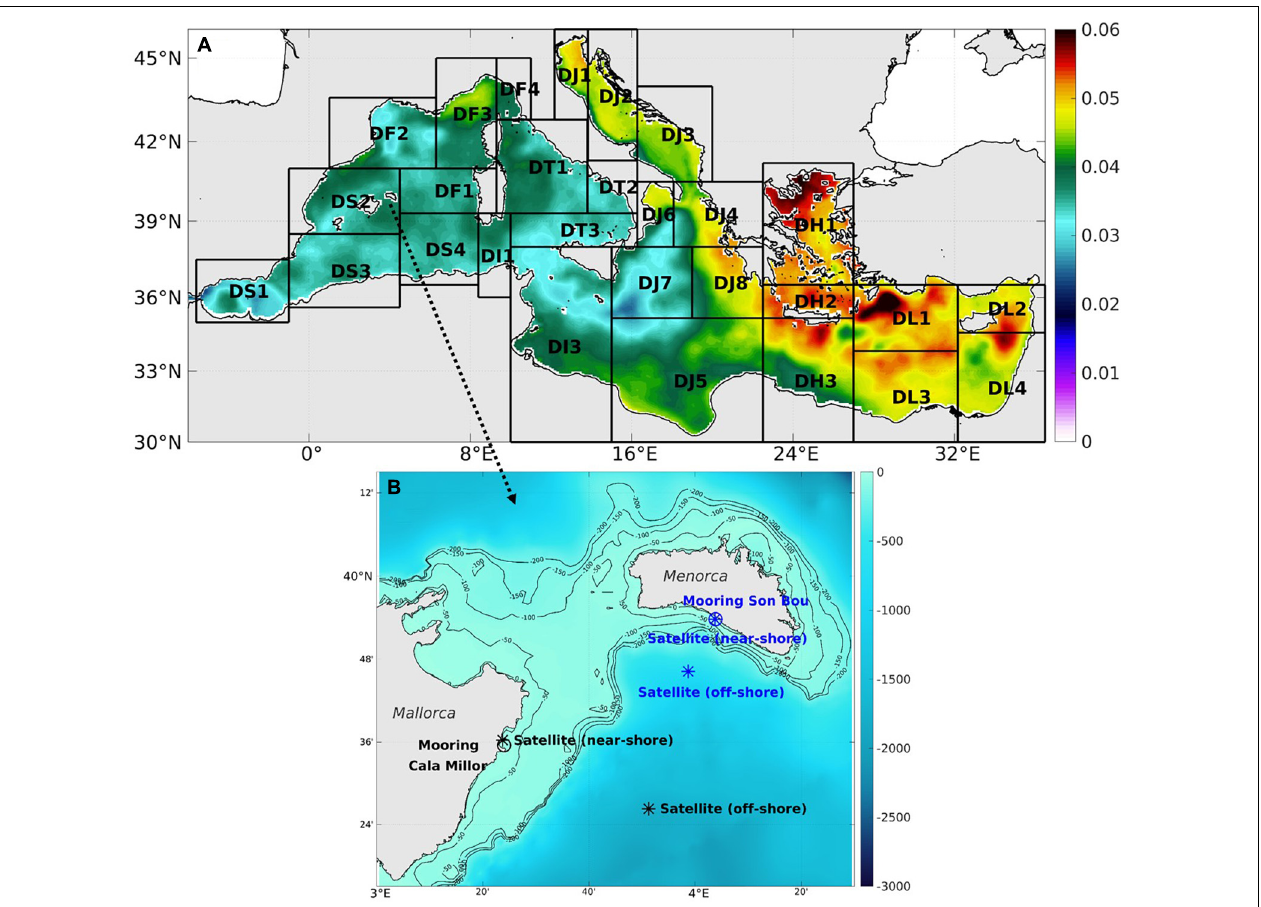
FIGURE 1 | (A) Linear trend estimations of SST over 1982–2020 in the Mediterranean Sea (in ◦ C/year) with sub-regions as defined by Manca et al. (2004). (B) Zoom in the sub-region [DS2]: bathymetry (in m) (from Smith and Sandwell, 1997) with moorings at Cala Millor (at 39.59 ◦ N – 3.4 ◦ E, black circle) and Son Bou (at 39.9 ◦ N – 4.06 ◦ E, blue circle), and their closest near-shore (at 39.6 ◦ N – 3.4 ◦ E and 39.9 ◦ N – 4.06 ◦ E, respectively) and off-shore (at 39.44 ◦ N – 3.85 ◦ E and 39.77 ◦ N – 3.98 ◦ E, respectively) grid points from satellite product (stars).